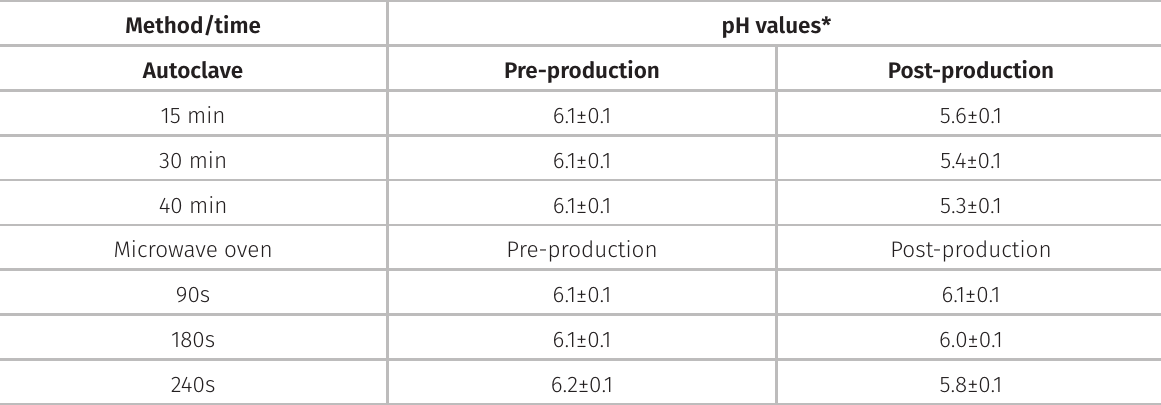
Table I. pH measurement of the SDA medium before and after autoclaving and